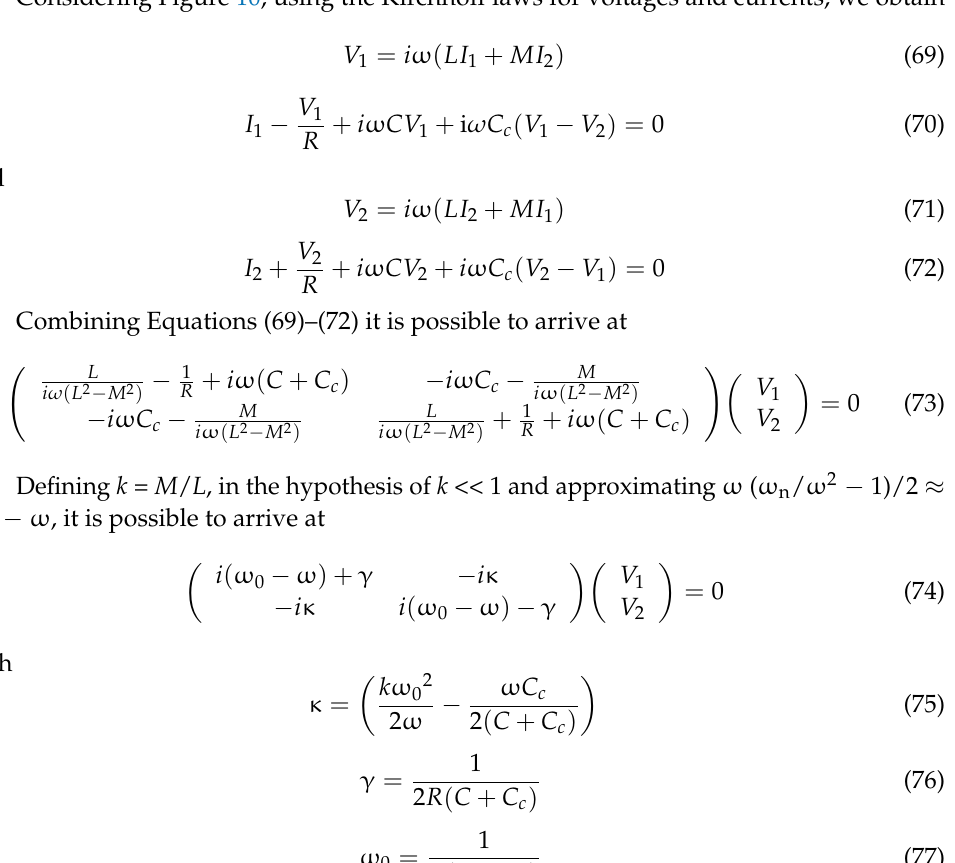
Figure 11. Realization of the negative resistor with a resistor and a 2 × amplifier.